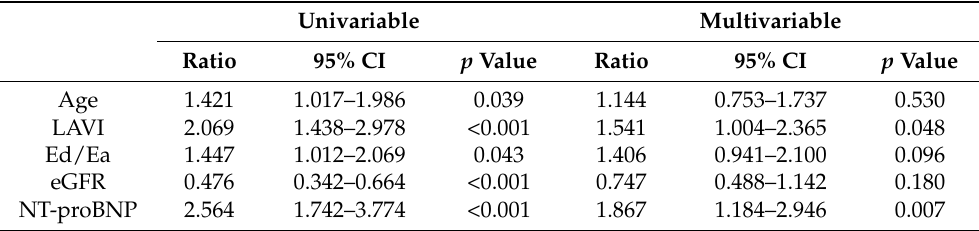
Table 3. Univariable and multivariable Fine–Gray analyses in re-admission for heart failure during the first year in all patients.